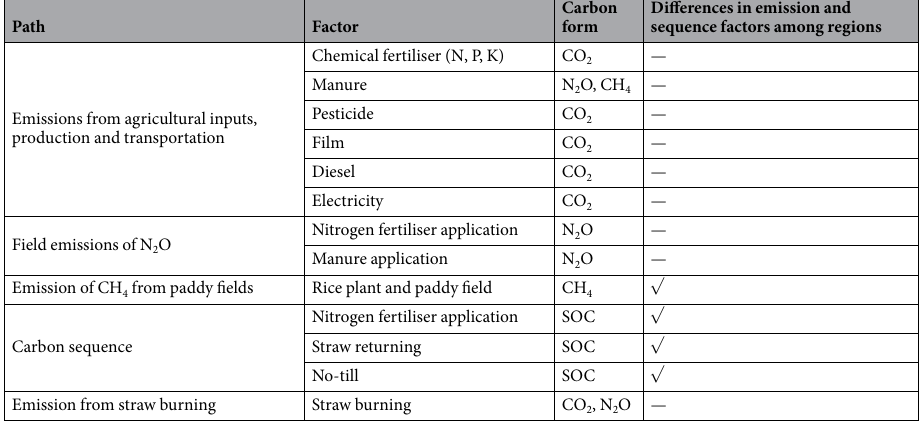
Table 4. Carbon forms in the carbon footprint